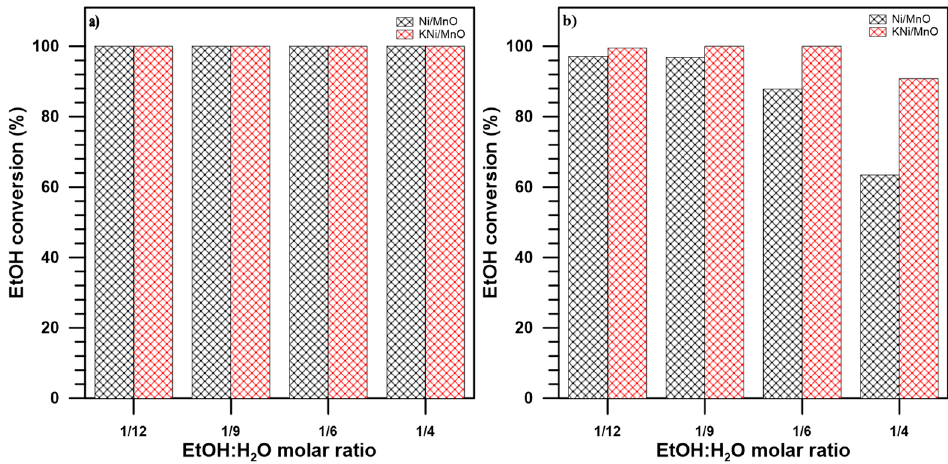
Figure 5. The ethanol conversion ( a ) at the beginning and ( b ) after 18 h of SRE process at 420 °C for H 2 O/EtOH molar ratio of 12/1, 9/1, 6/1, and 4/1 over Ni/MnO x and KNi/MnO x catalysts.